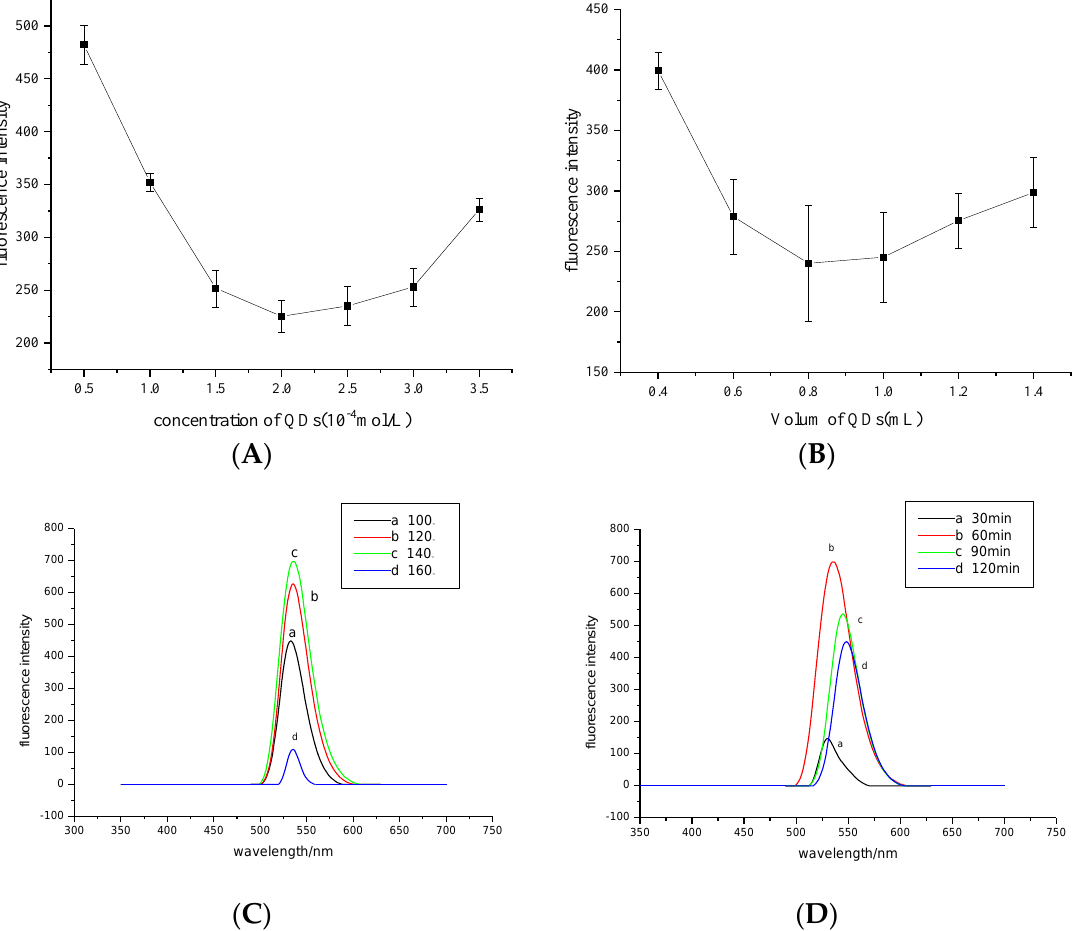
Figure 1. Influence of ( A ) the quantum dot concentration; ( B ) the amount of CdTe QDs; ( C ) different heating temperatures; and ( D ) different reaction times.